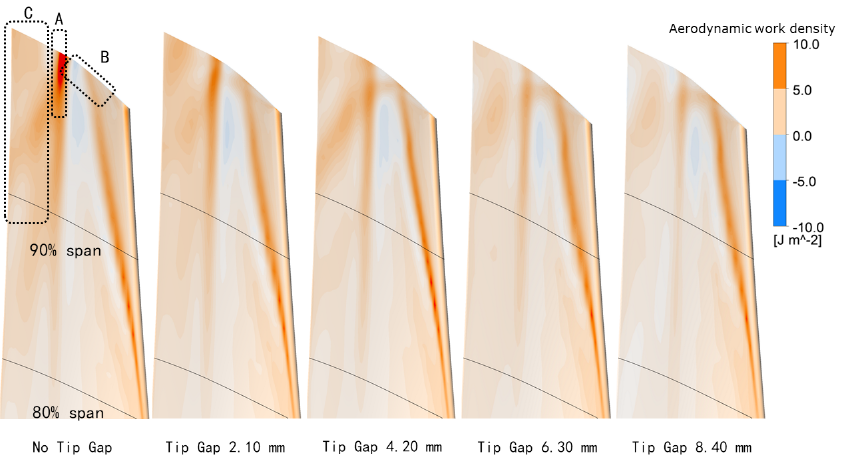
Figure 11. Distribution of the aerodynamic work coefficient on the suction side of rotor near the tip when IBPA = −